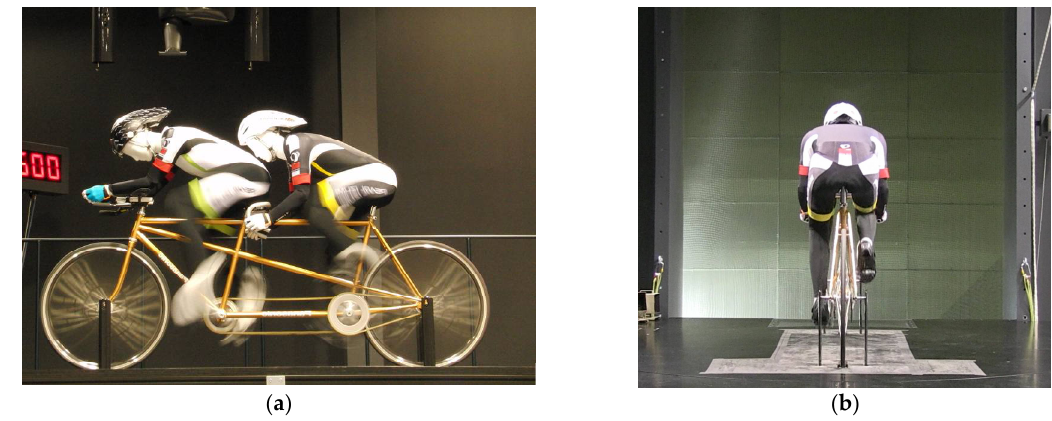
Figure 3. Wind tunnel test of a tandem bike. Both mannequins can pedal: ( a ) Side view; ( b ) Back